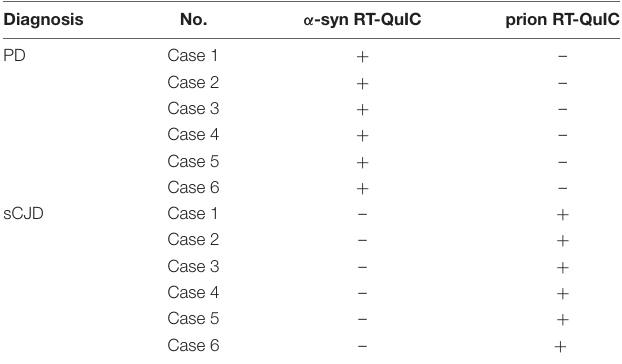
TABLE 4 | The reactivities of the skin samples (10 − 4 diluted) from six PD cases and six sCJD cases in α -syn RT-QuIC and prion RT-QuIC assays. Diagnosis No. α -syn